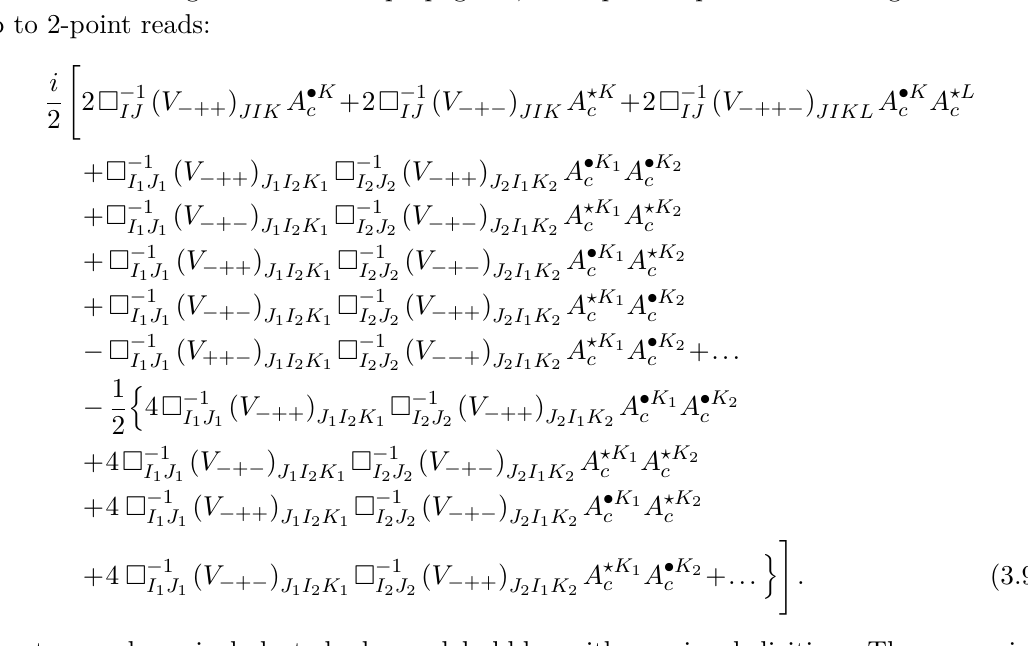
or ˆ A ? field attachments. c c